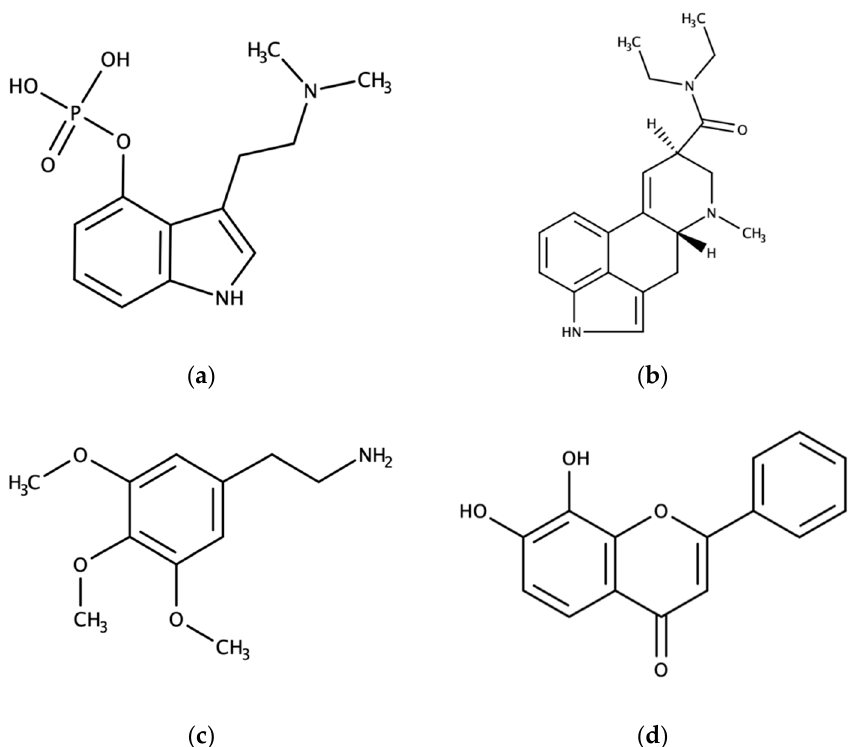
Figure 1. Molecular structures of: ( a ) Psilocybin; ( b ) LSD (lysergic acid diethylamide); ( c ) mescaline; ( d ) 7,8-DHF (7,8-dihydroxyflavone).